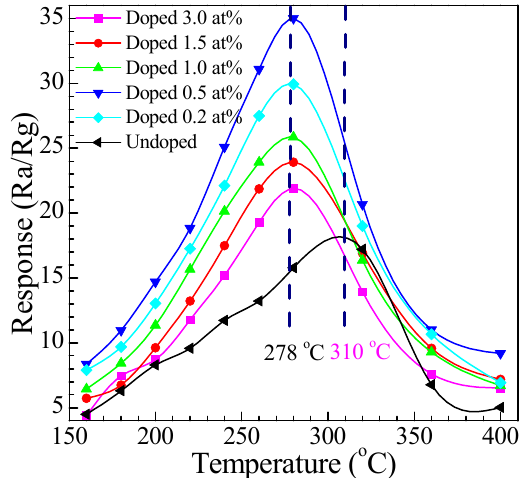
Figure 8. Responses of Eu-doped SnO 2 nanorods array sensors toward 200 ppm methanal at different operating temperature.